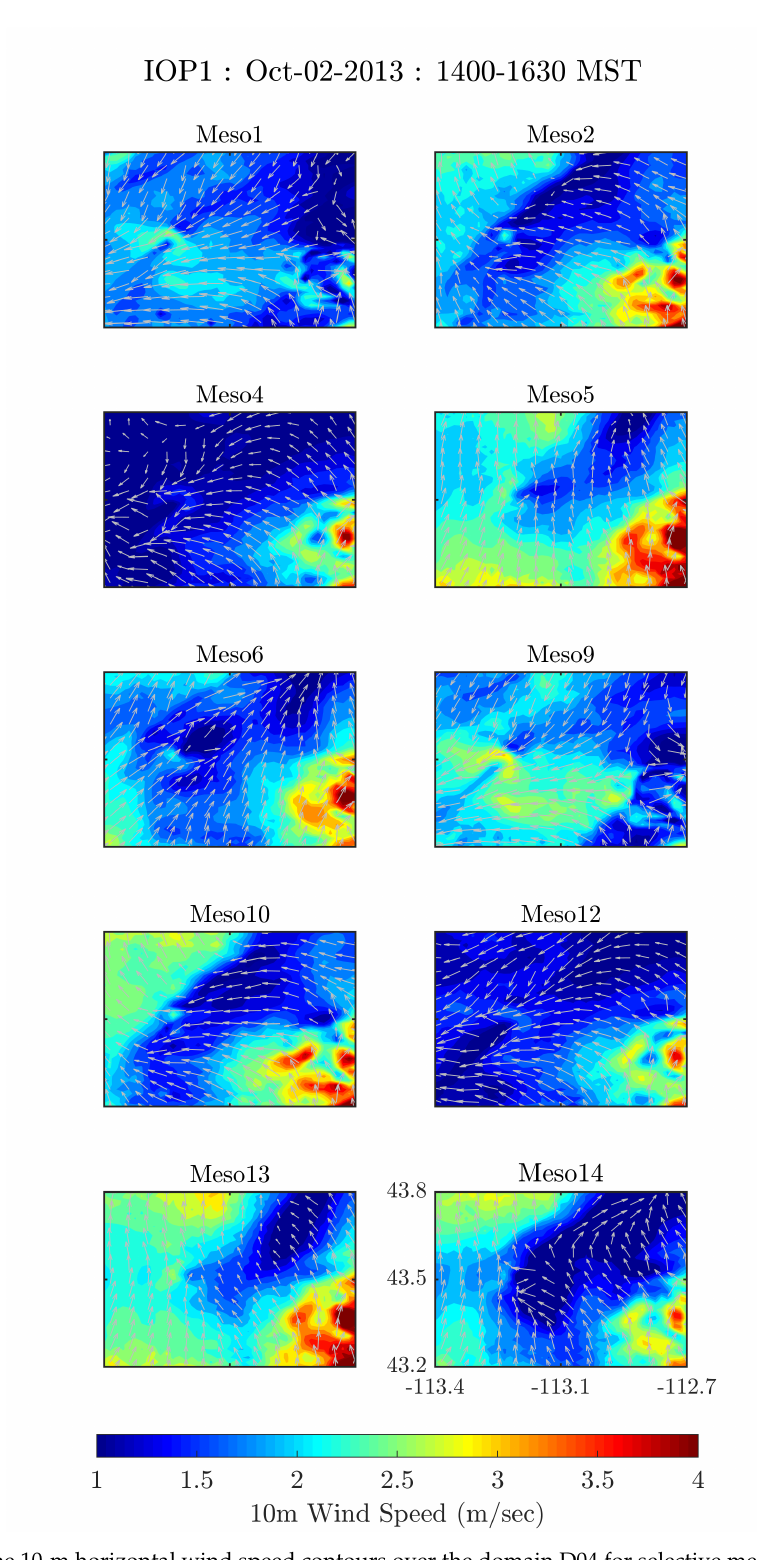
Figure 2. The 10-m horizontal wind speed contours over the domain D04 for selective mesoscale cases during IOP1. Gray arrows represent normalized wind vectors drawn at every other third grid